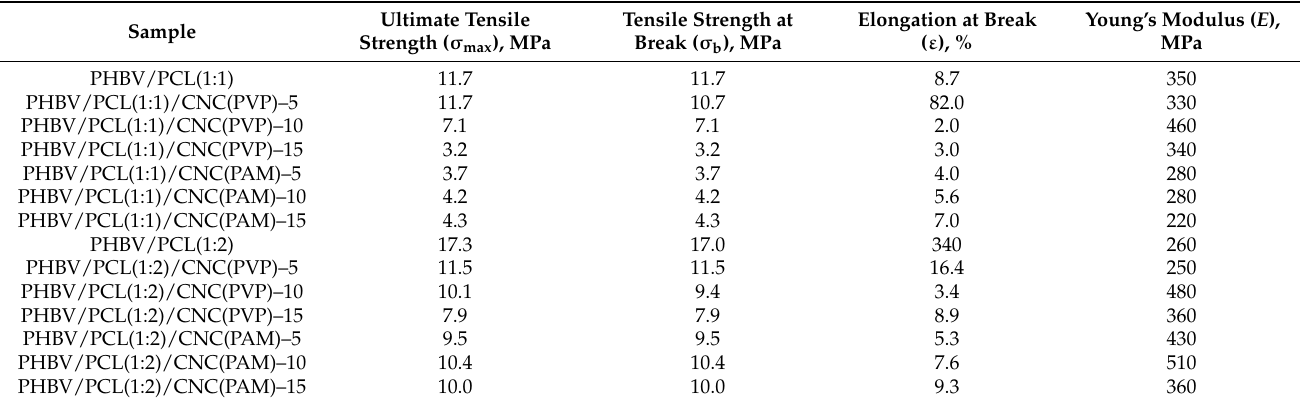
Table 5. Tensile properties of the PHBV/PCL mixtures and PHBV/PCL/CNC composites 1